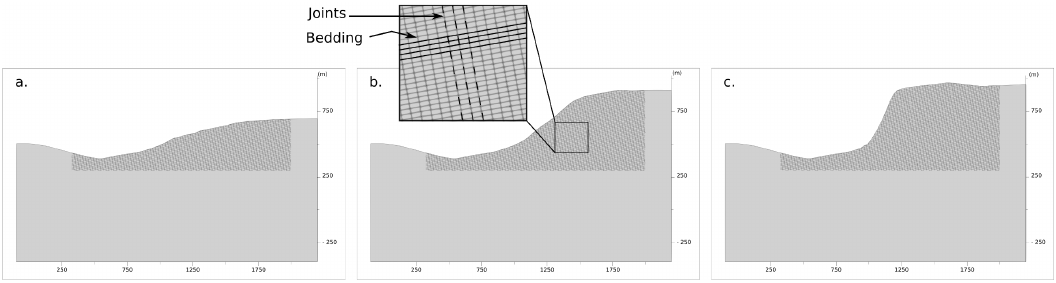
Figure 13. Three slope morphologies corresponding to ( a ) a gentle slope; ( b ) a medium slope (Balta case); ( c ) a steep